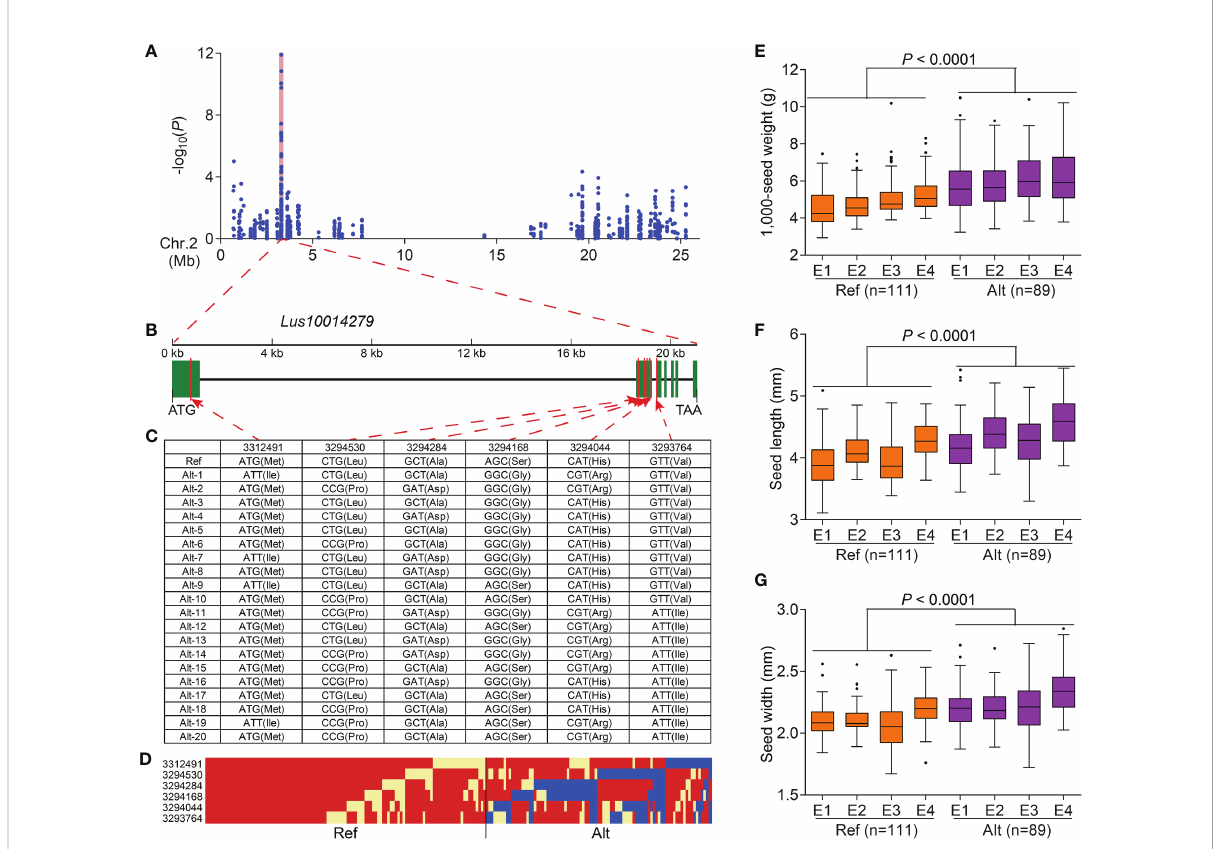
FIGURE 5 Identi fi cation of a seed size – related candidate gene on chromosome 2. (A) Local Manhattan plots for 1,000-seed weight in 2016DL on chromosome 2, and a shaded pink column highlights the position of Lus10014279 . (B) Gene structure of Lus10014279 . Green rectangles and black line represent exons and introns, respectively. (C) DNA polymorphism in Lus10014279 . (D) Schematic diagram of the structural variation in Lus10014279. (E – G) Box plots for 1,000-seed weight (E) , seed length (F) , and seed width (G) based on the haplotypes for Lus10014279 in 2016DL (E1), 2017UR (E2), 2019UR (E3), and 2019YL (E4). The difference was analyzed by two-tailed t